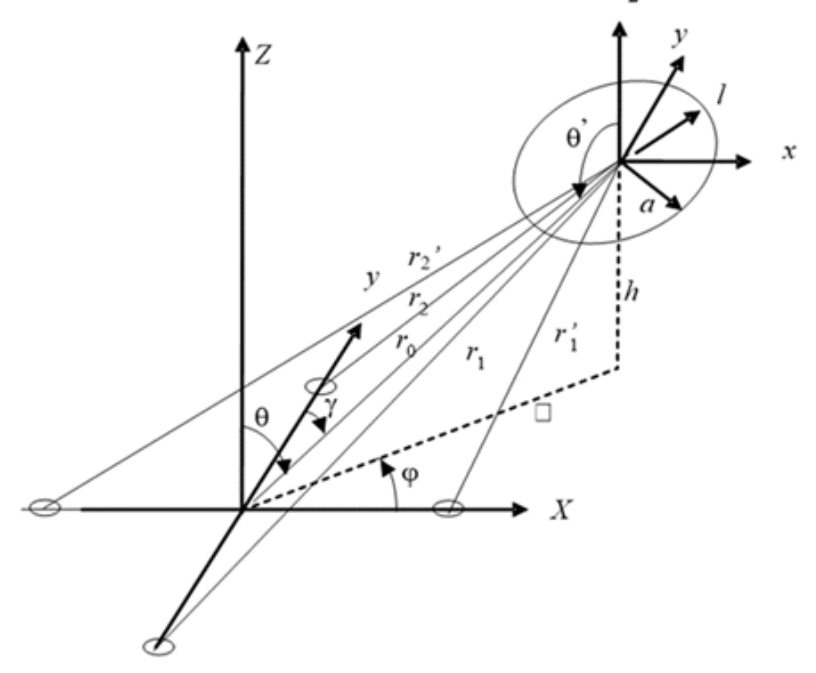
Figure 1. The layout of the electrode antennas and the spheroid in the layer.